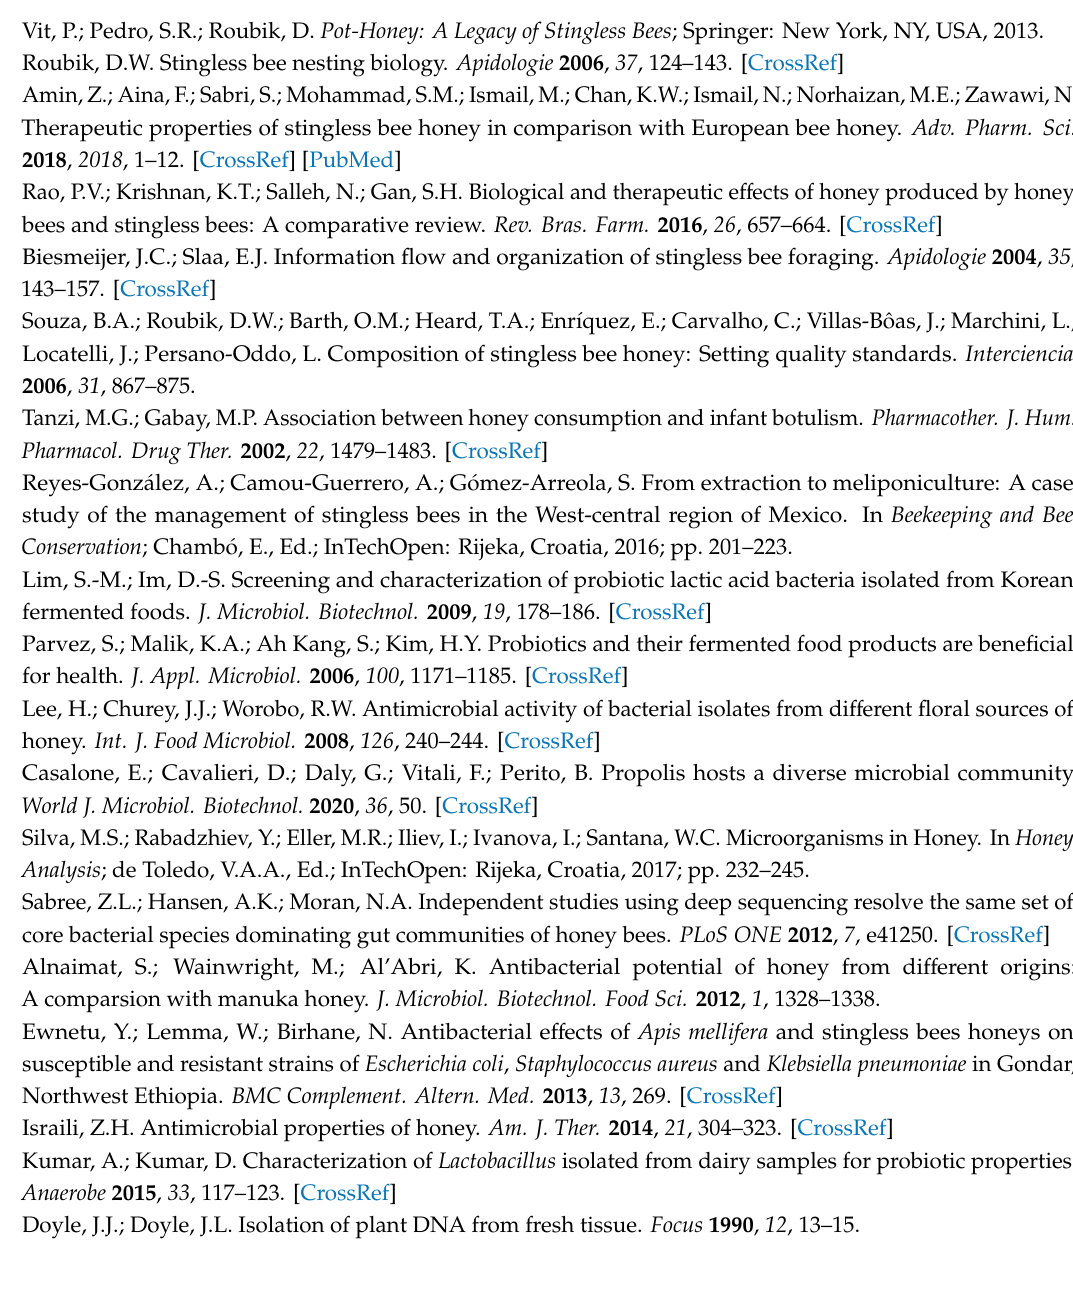
Table S1: Percentage Abundance of Top Seven OTU Bacteria (OTU%). Table S2: Percentage Abundance of Top Bacterial Genus (OTU%). Figure S1: Rank abundance curve of bacterial composition in honey from eight di ff erent stingless bee